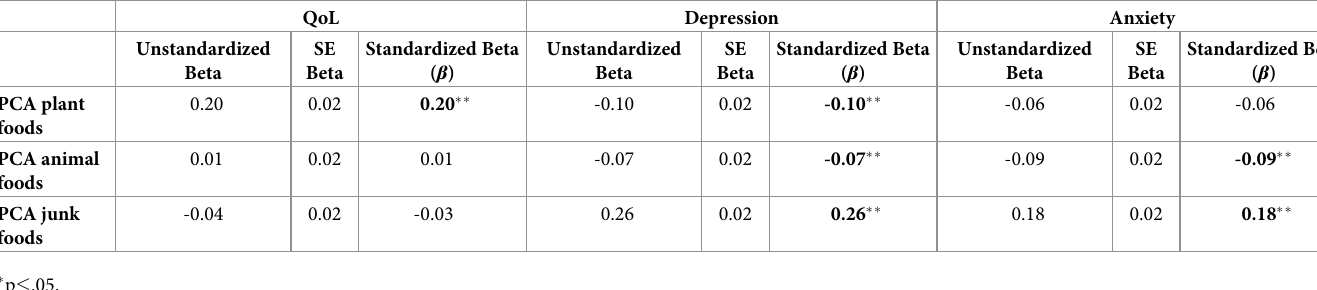
Table 5. Unadjusted effects of principal component analysis (PCA) diet components on quality of life (QoL), depression, and